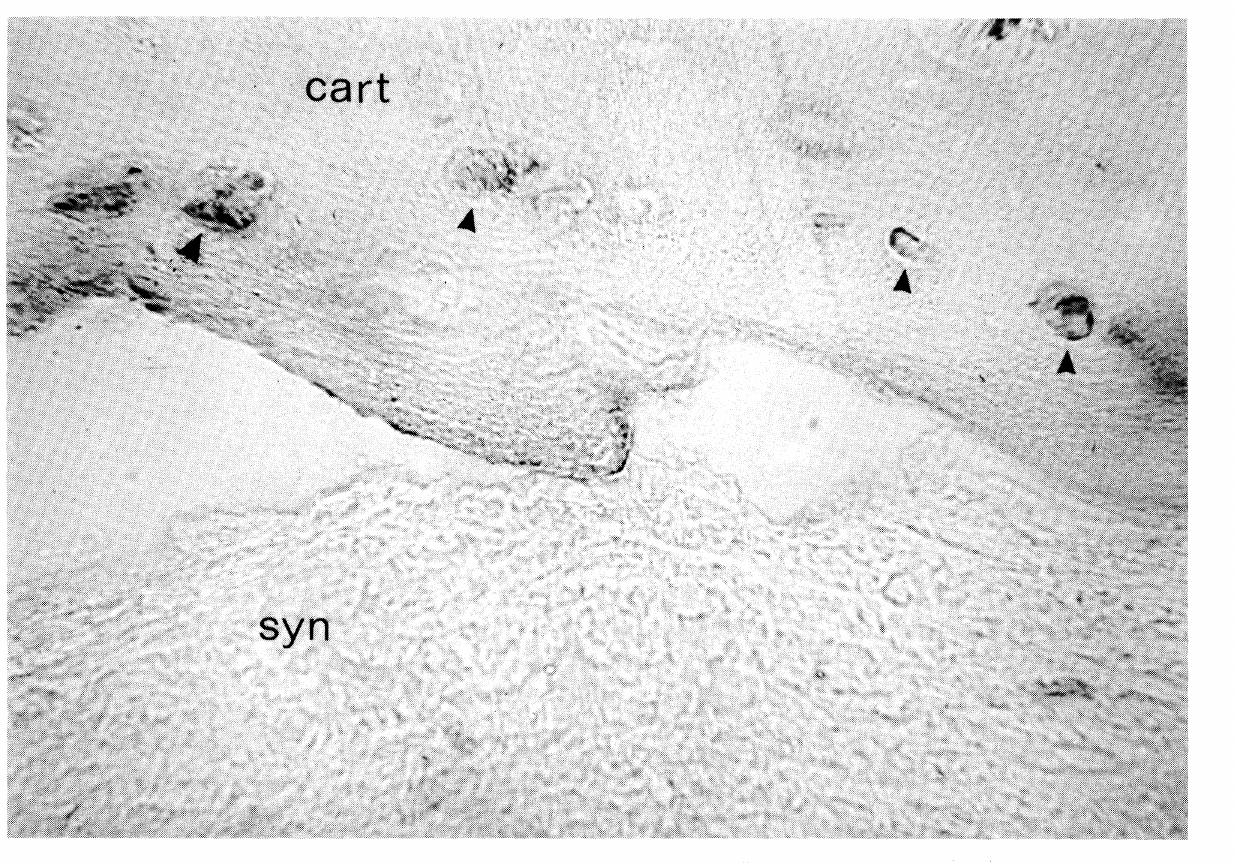
FIG. 1. Expression of ICAM-1 on chondrocytes (arrowed) in human rheumatoid arthritic